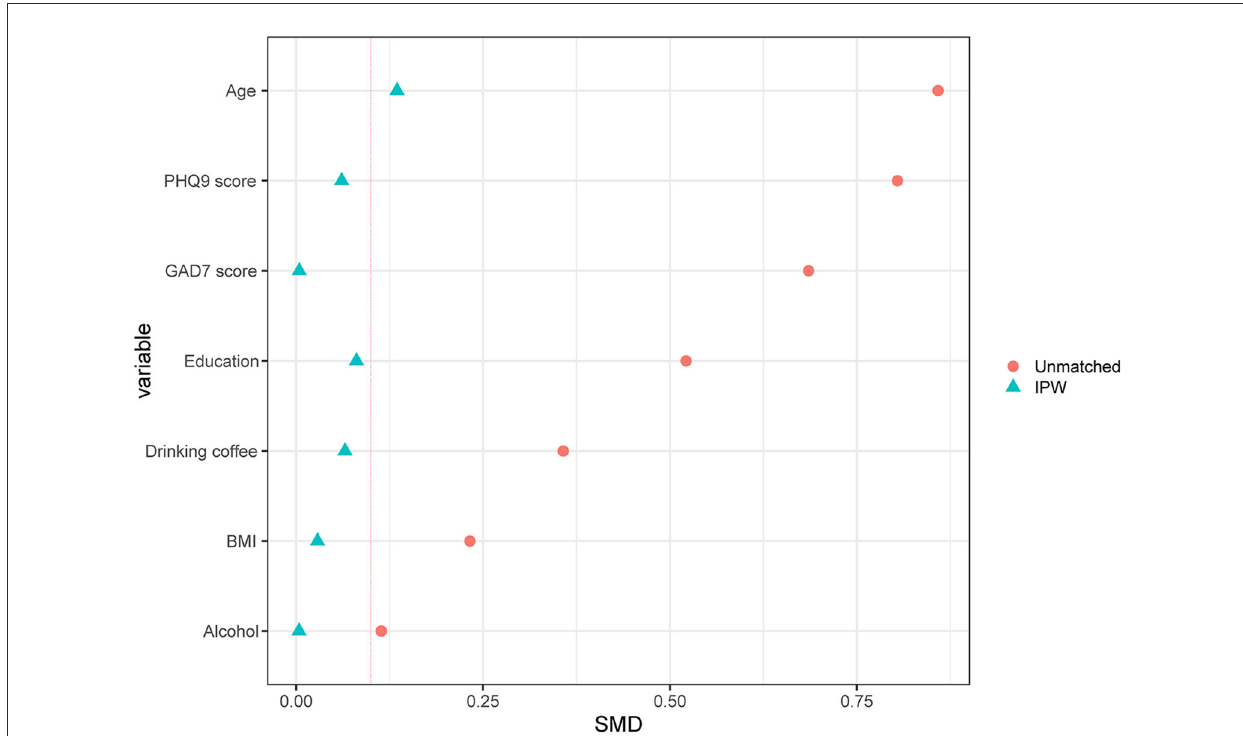
FIGURE2 Standardized differences shown for each confounder variable of RLS. The X-axis represents the standardized differences value, and the Y-axis represents baseline variables. The red vertical line signifies the standardized differences cutoffs of > 0.1. RLS, right-to-left shunt; IPW, inverse probability weighted; SMD, standardized mean